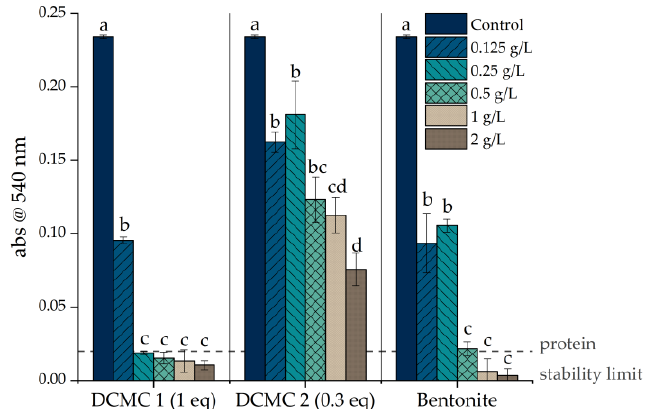
Figure 4. Heat stability test results of Primavera wine treated with DCMC 1, DCMC 2, and bentonite. Different letters represent significant differences among different homogeneous subsets for p = 0.05.